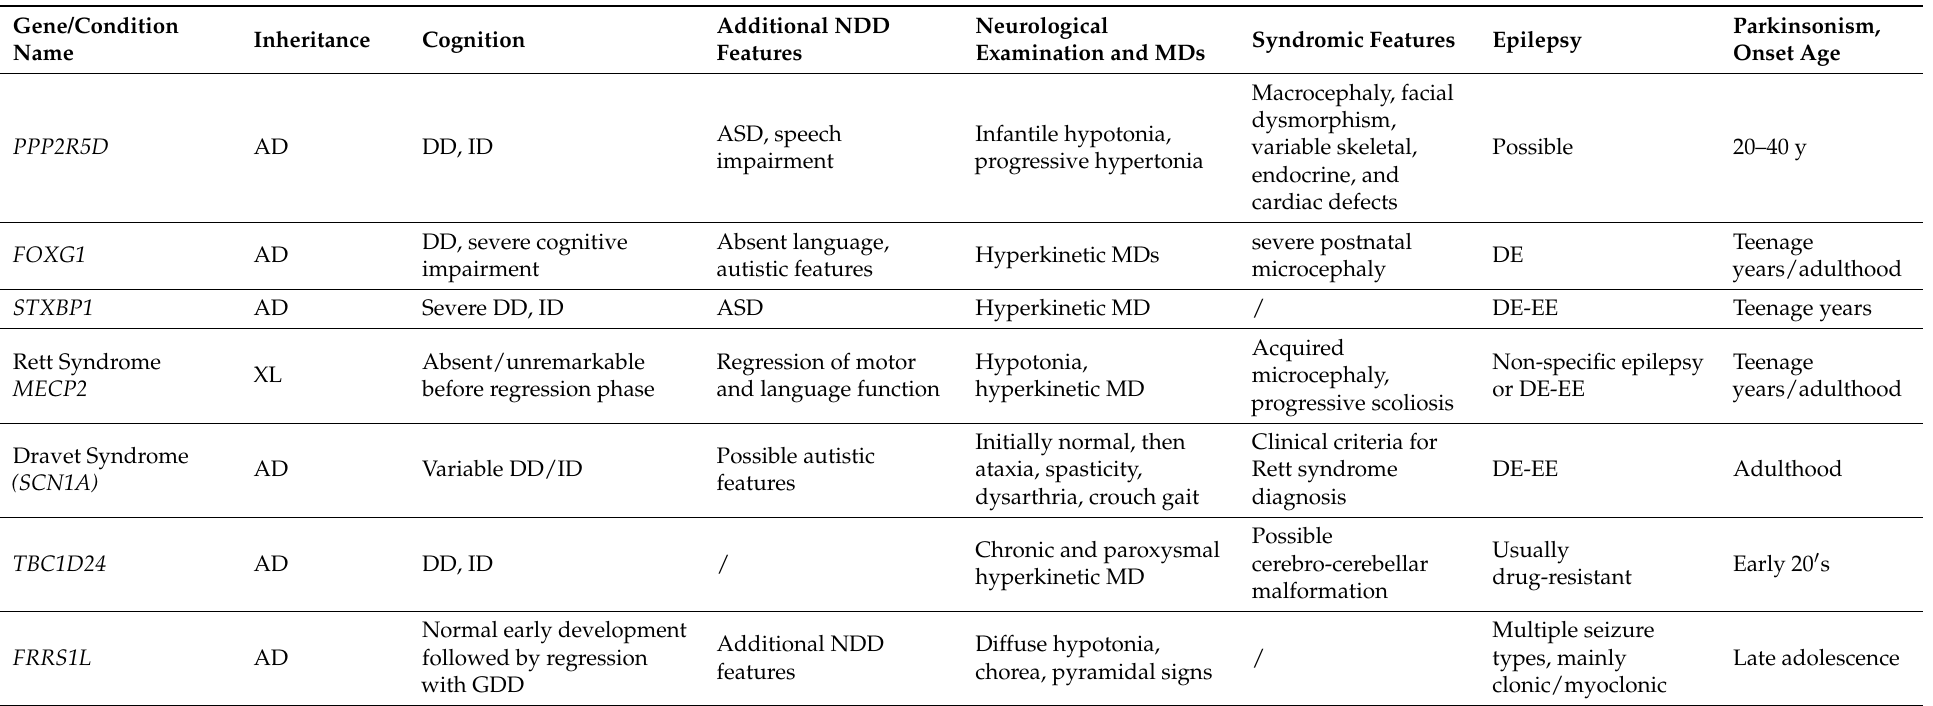
Table 1. Neurodevelopmental disorders and DE-EE with